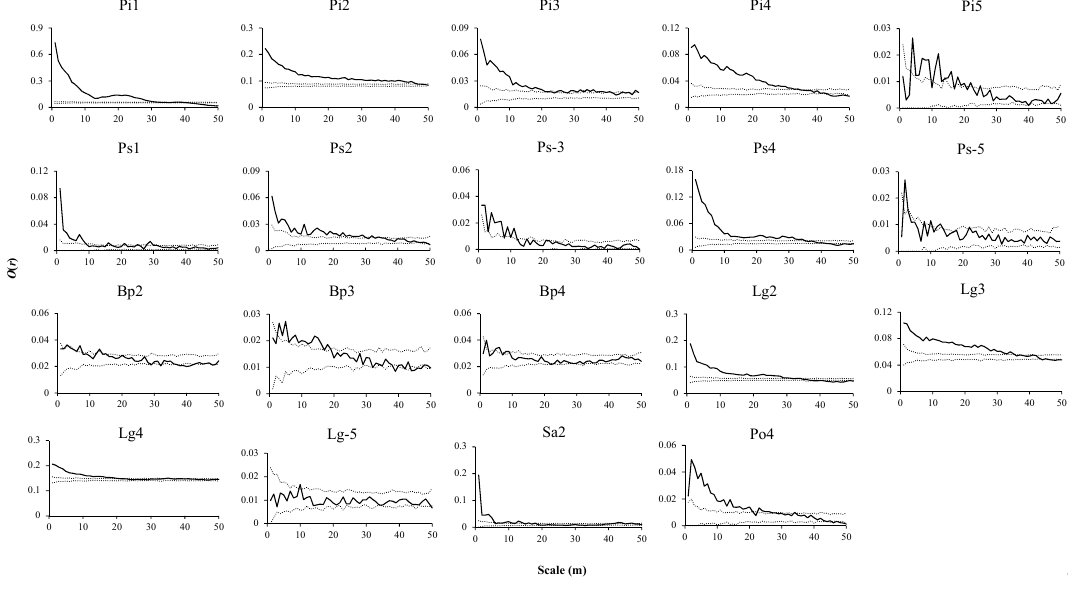
Figure 4. Spatial distributions of tree species in CMF.